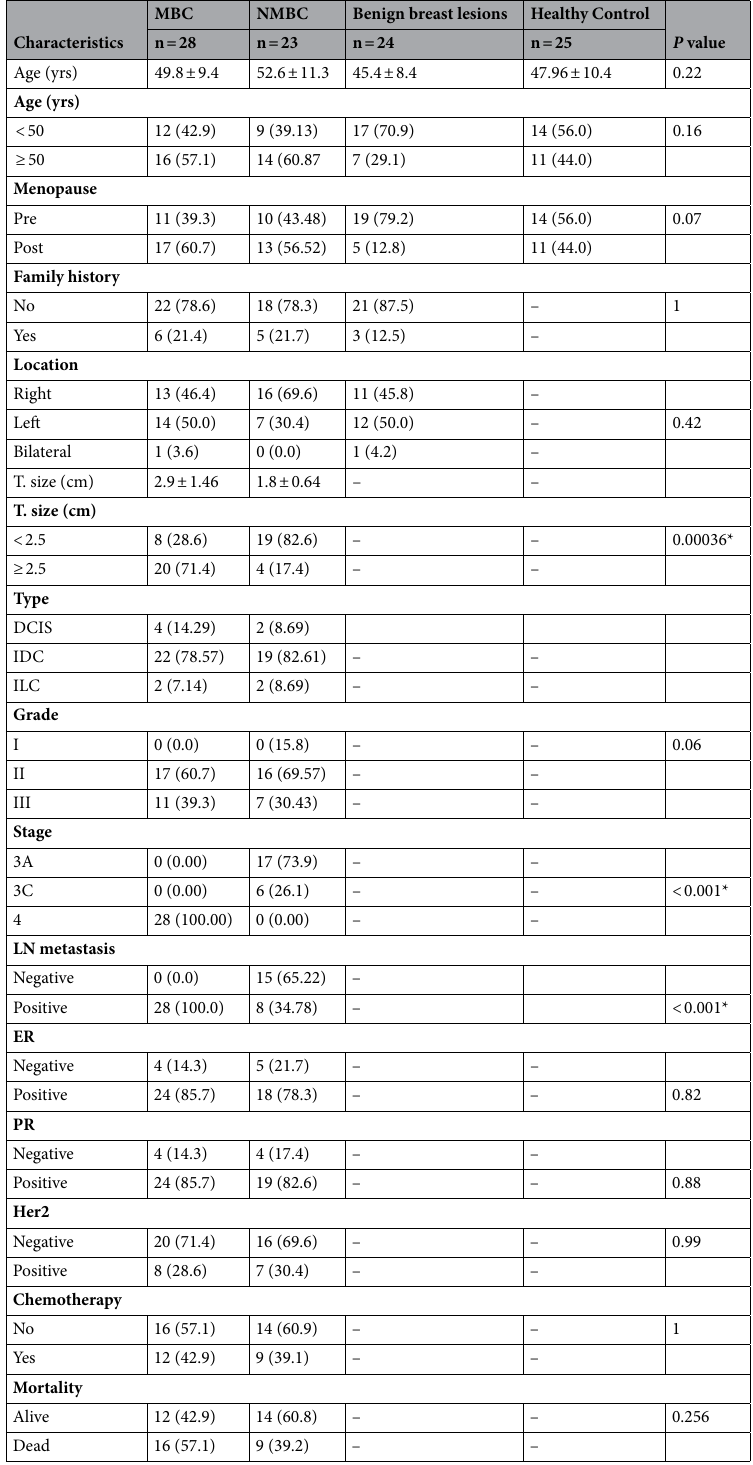
Table 1. Demographics of study participants and clinicopathological characteristics of metastatic and non- metastatic breast cancer patients. MBC; metastatic breast cancer, NMBC, non-metastatic breast cancer, B, benign breast disease, NC; normal control, T. size; tumor size; DCIS; ductal carcinoma in situ, IDC; invasive ductal carcinoma, ILC; invasive lobular carcinoma, LN; lymph node, ER; estrogen receptor, PR; progesterone receptor, HER2; human epidermal growth factor